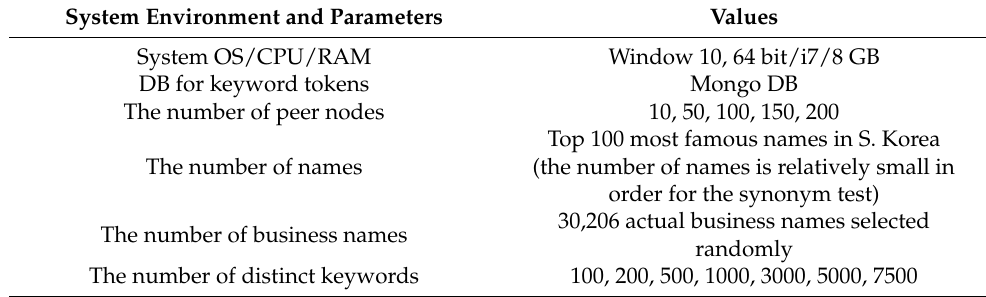
Table 4. Simulation Parameters and